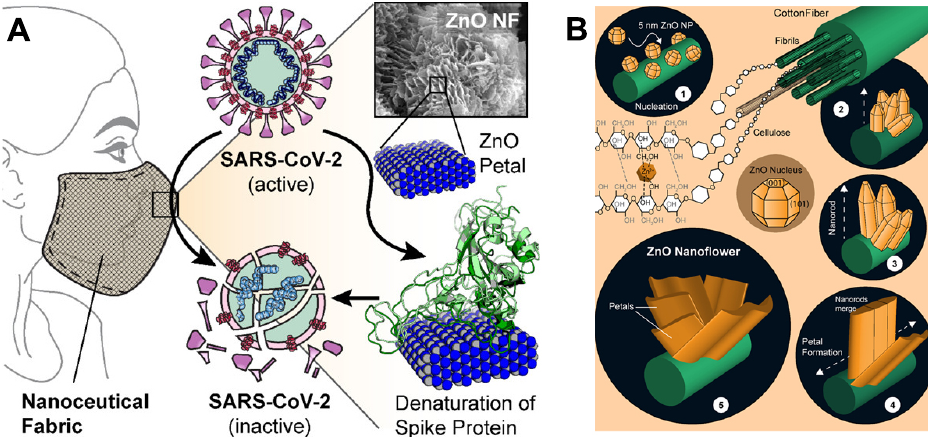
Figure 8. ( A ) Schematic representation showing how ZnO petals added to nanoceutical cotton fabric may induce a denaturation of the spike protein; ( B ) The five steps for growing ZnO nanoflowers on cotton cellulose fibers. Reprinted with permission from Adhikari et al. Nanoceutical Fabric Prevents COVID-19 Spread through Expelled Respiratory Droplets: A Combined Computational, Spectroscopic, and Antimicrobial Study. ACS Applied Bio Materials , 2021 4 (7), 5471–5484. Copyright 2021 American Chemical Society